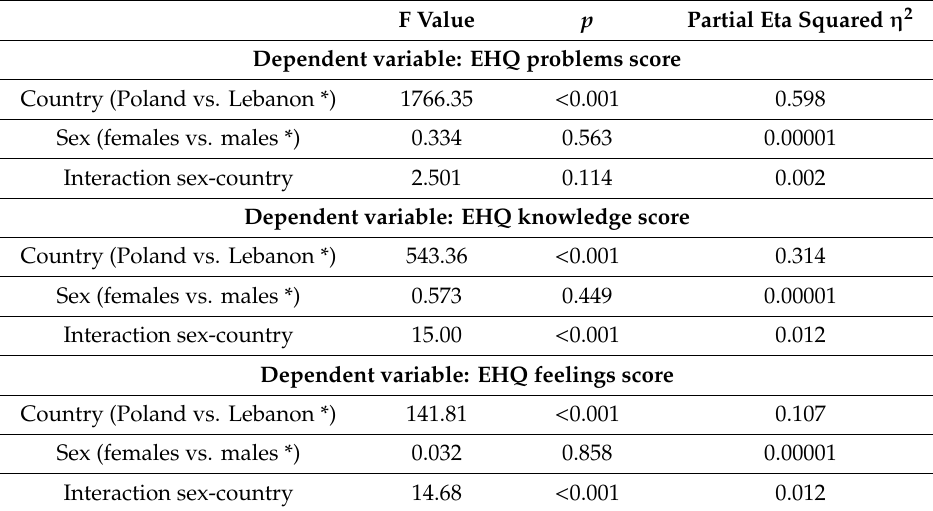
Table 6. Two-factor ANOVA results of the country and sex e ff ect on the EHQ subscales scores.